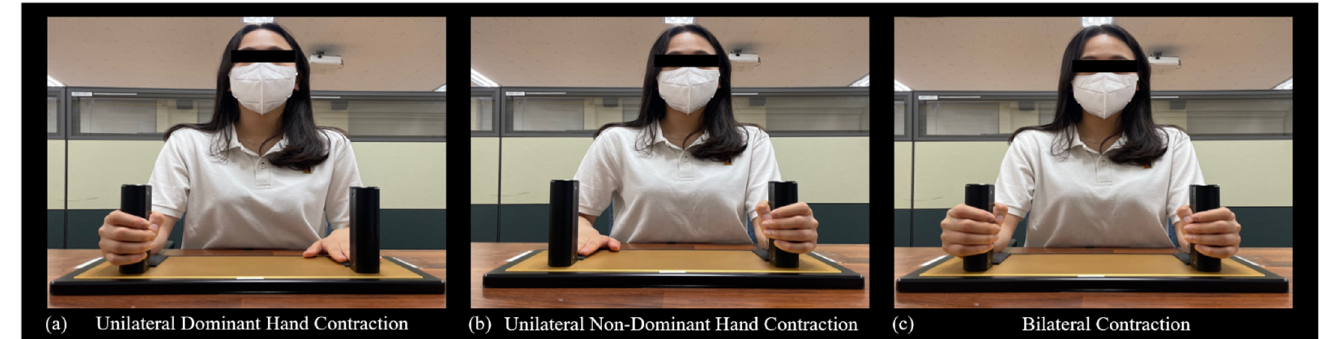
Figure 1. Hand-grip force production task. ( a ) Unilateral dominant hand contraction, ( b ) Unilateral nondominant hand contraction, and ( c ) Bilateral hands contraction.